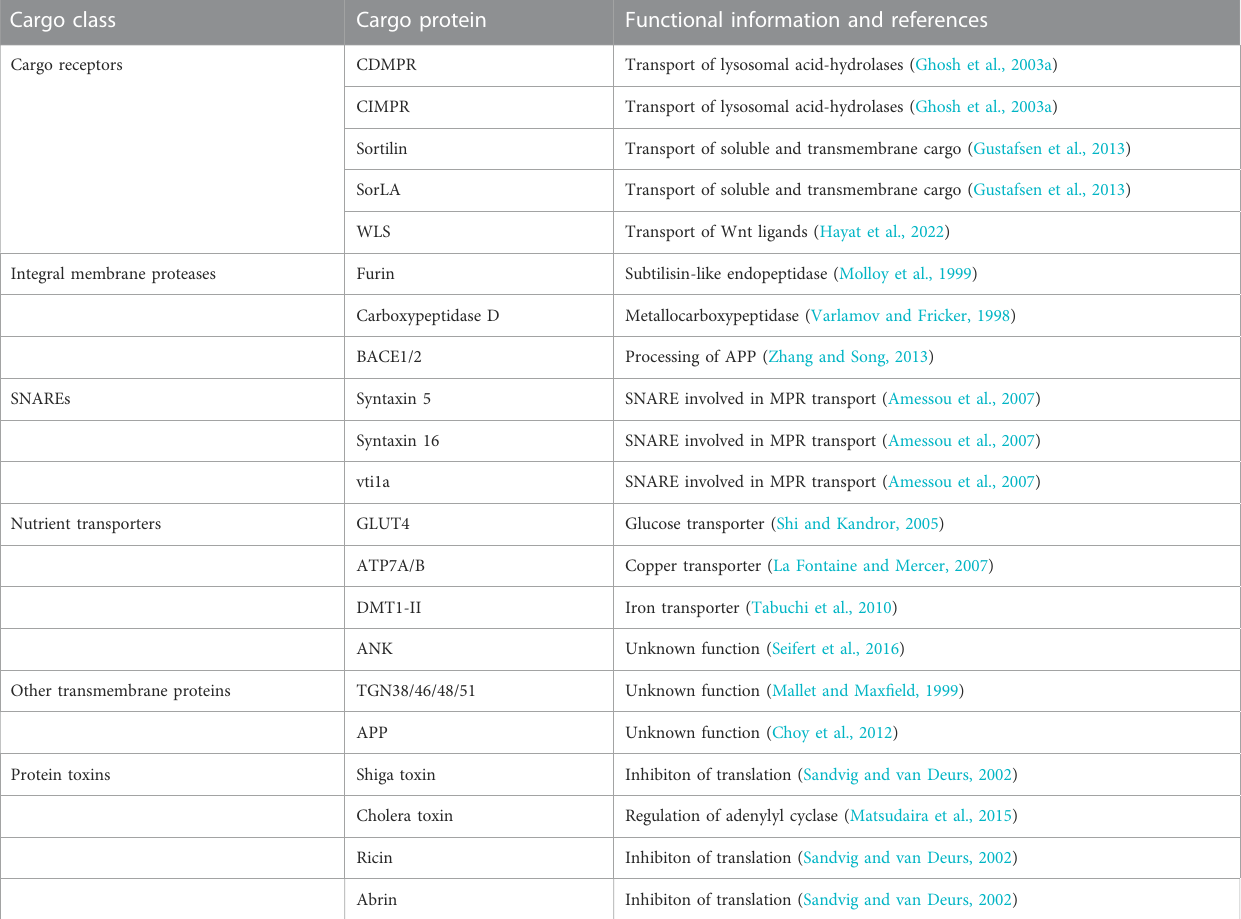
TABLE 1 Selection of cargo proteins that undergo retrograde transport from endosomes to the